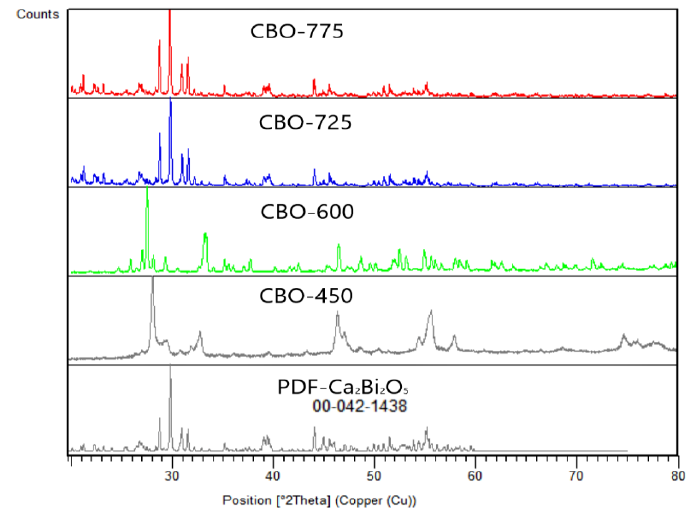
Figure 1. XRD diffractograms of CBO samples calcinated at different temperatures.